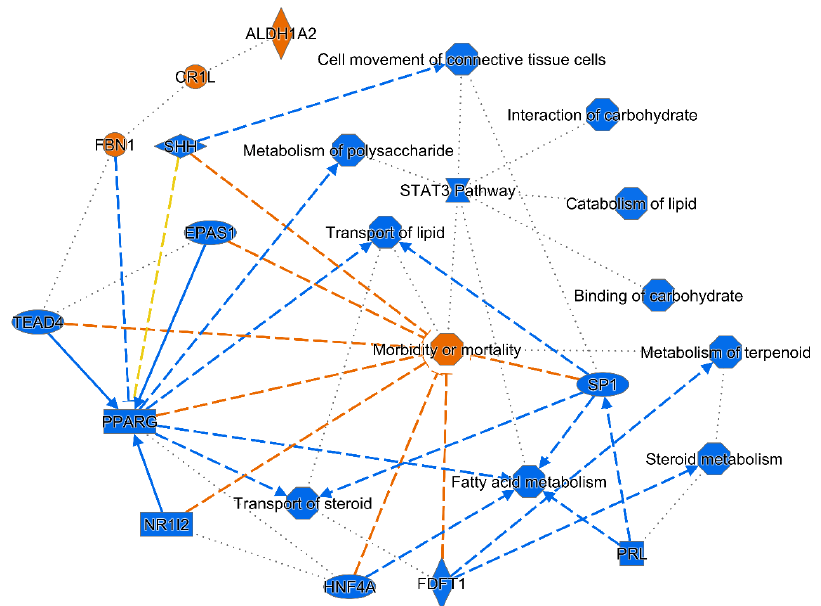
Figure 7. Graphical summary of hepatic transcriptome changes in SD Nme7 − / − rats. The connected subset of the most significant entities within the analysis (upstream regulators, diseases, and biological functions) performed using the machine-learning-based algorithm implemented in the Ingenuity Pathway Analysis is shown. Full and dashed lines correspond to direct and indirect interactions between two entities retrieved from the literature, the inferred edges are shown with dotted lines. The blue color indicates predicted inhibition/downregulation, the orange color indicates predicted activation/upregulation, the yellow lines indicate relationships inconsistent with literature findings for the state of interest.